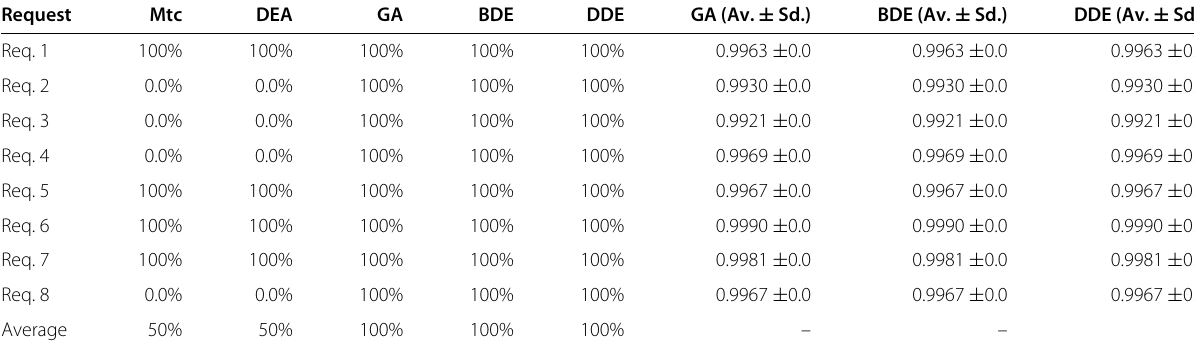
Table 8 Hit percentage results for 200 CPs without arbitrary price decrease (multiple global